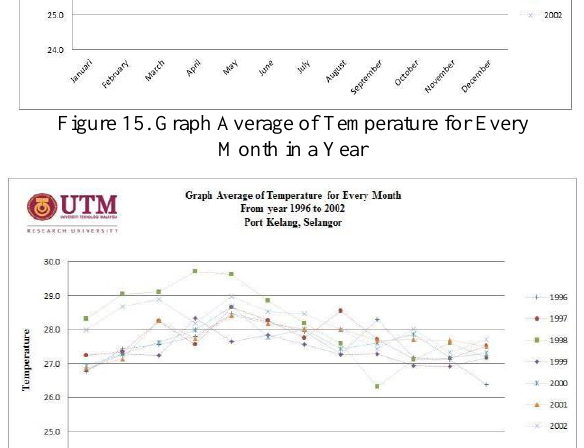
Figure 16. Graph Average of Temperature for Every